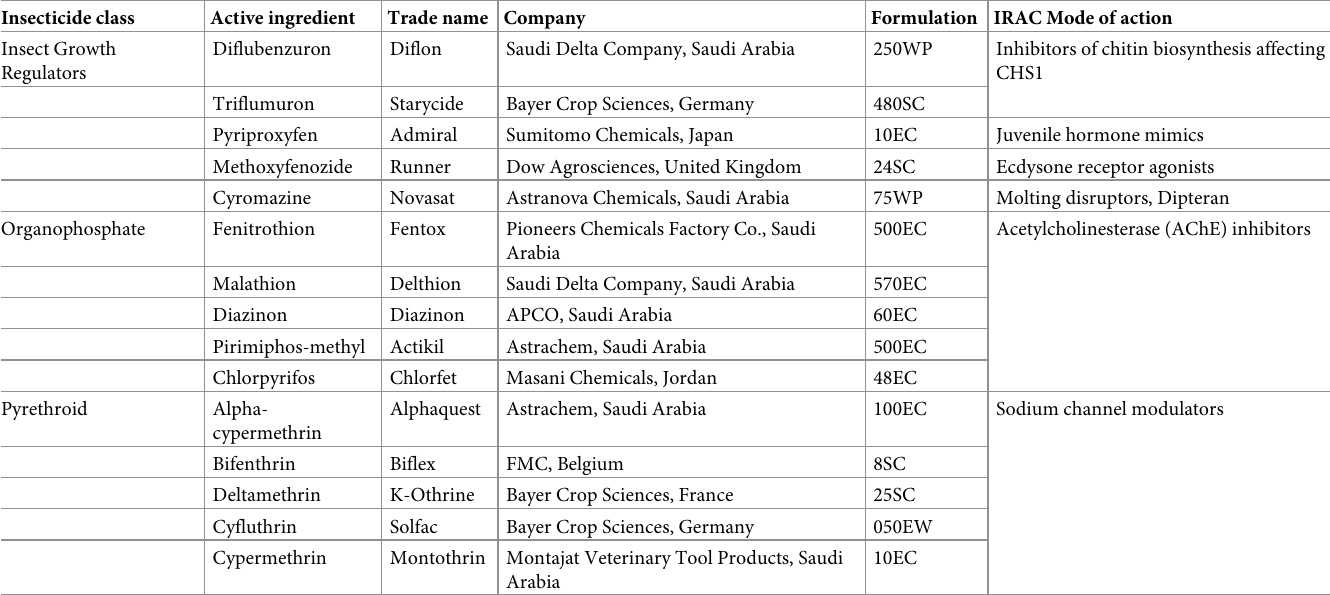
Table 1. The list of tested